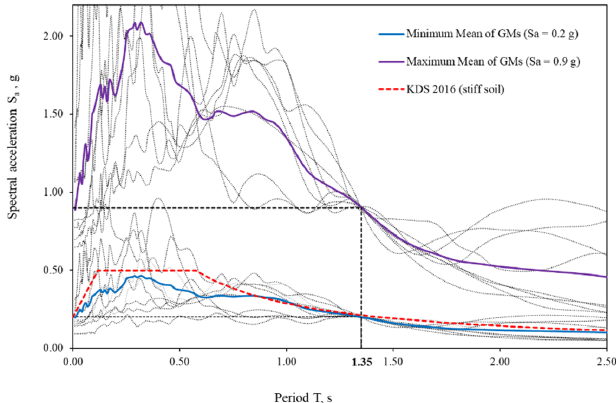
Figure 6. Scaled response spectra at the fundamental period.